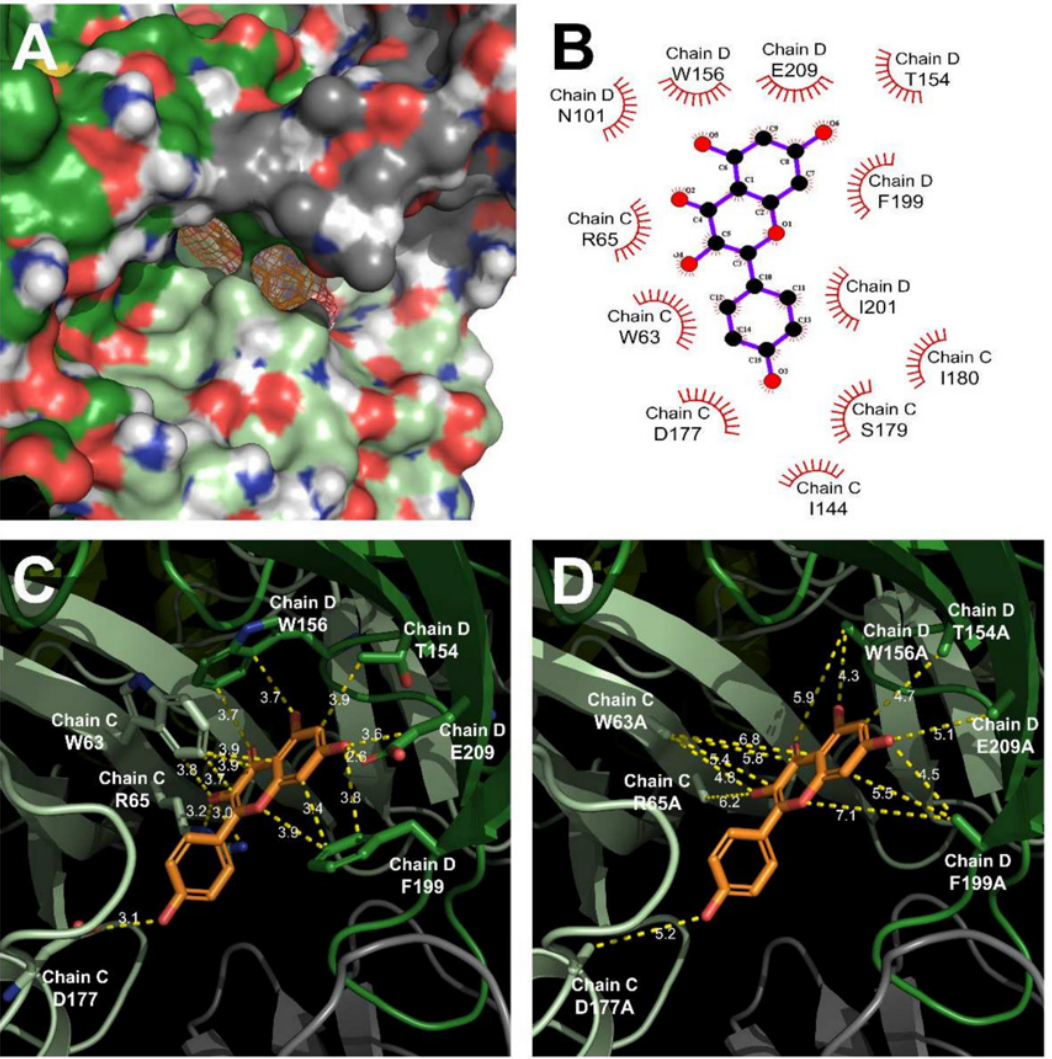
Figure 4. KAE binding pocket and docking modeling of human 5-HT 3A receptor by 3D protein modeling. ( A ) 5-HT 3A protein surface modeling on KAE binding site. KAE is docked between the two A subunits of the extracellular domain (ECD). ( B ) Interaction residues of KAE in 5-HT 3A are predicted by 2D schema. ( C ) Interaction energy of KAE between the two A subunits of the wild-type human 5-HT 3A receptor. ( D ) Interaction energy of KAE between the two A subunits of the mutant-type human 5-HT 3A receptor. Distances between each chain, residue, and atom are shown in the